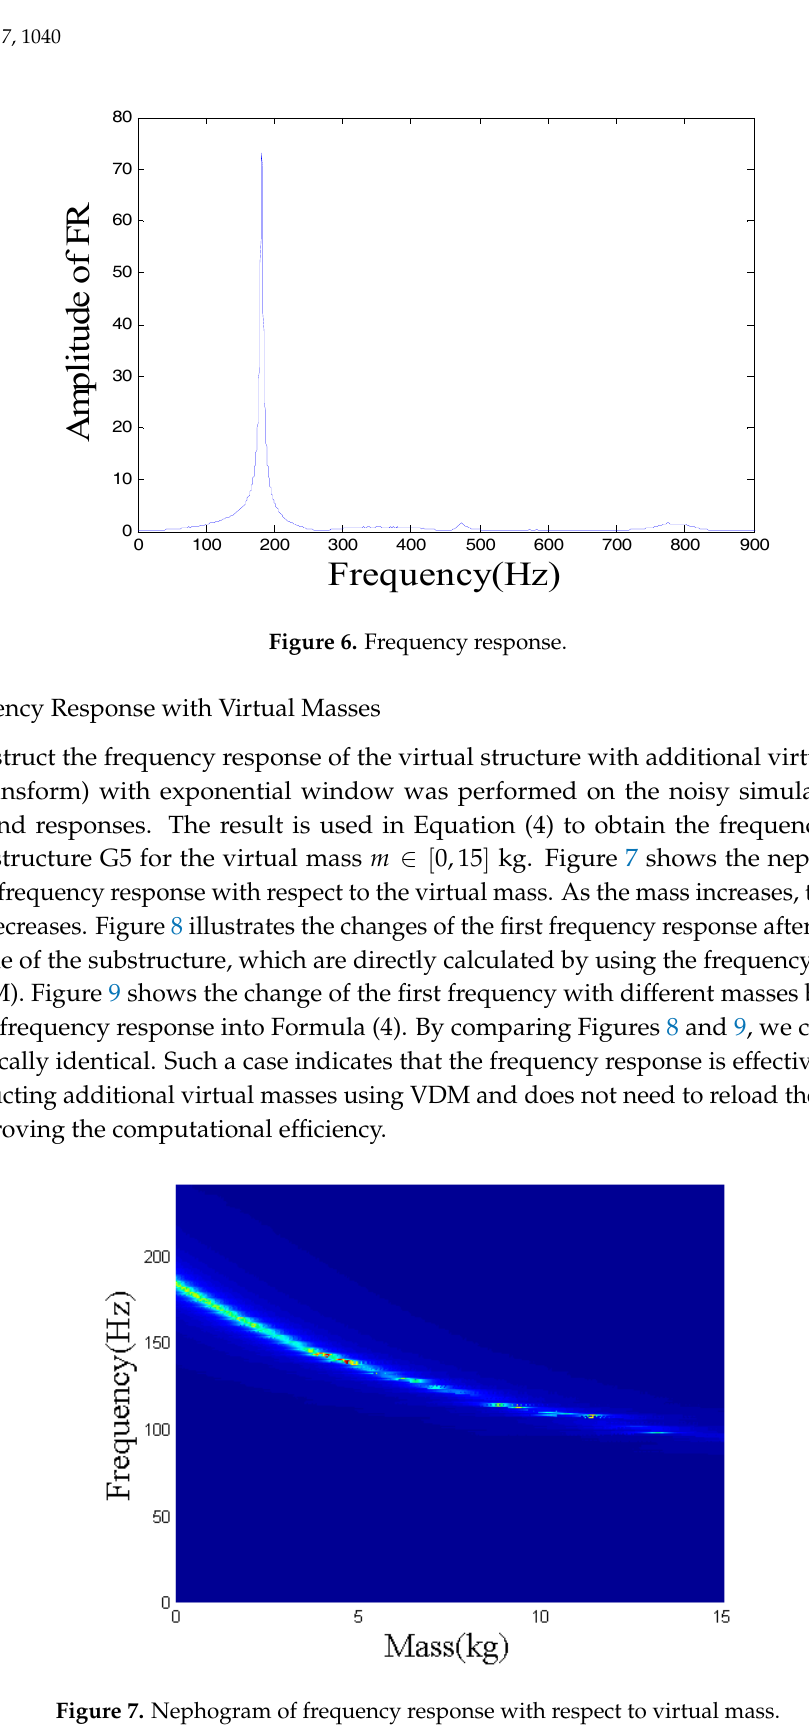
Figure 5. Acceleration response.